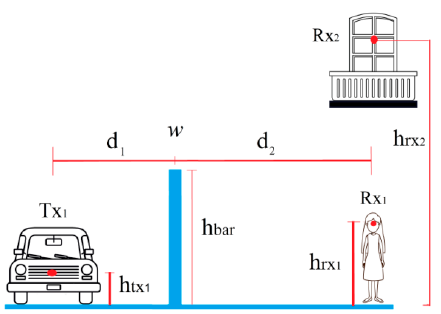
Figure 3. Car configurations (‘1 ′ , person, and ‘2 ′ , balcony).